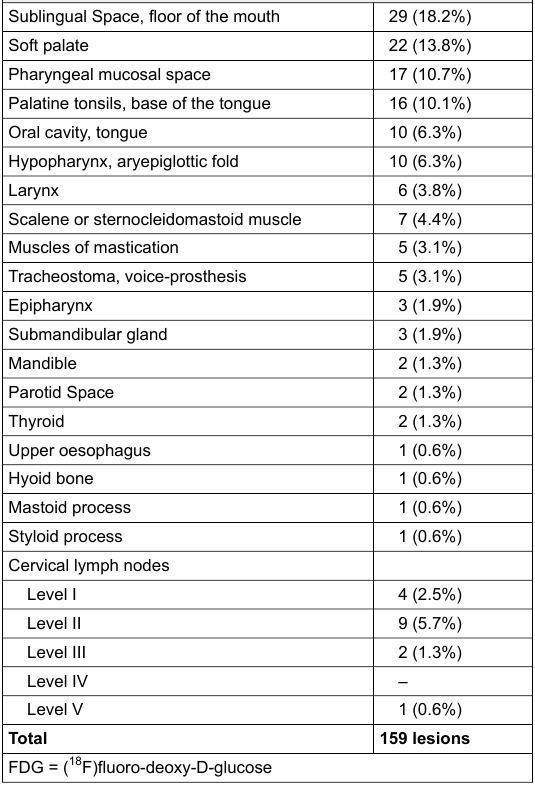
Table 2: Detailed information on all 159 FDG-positive lesions in the subgroup of disease-free